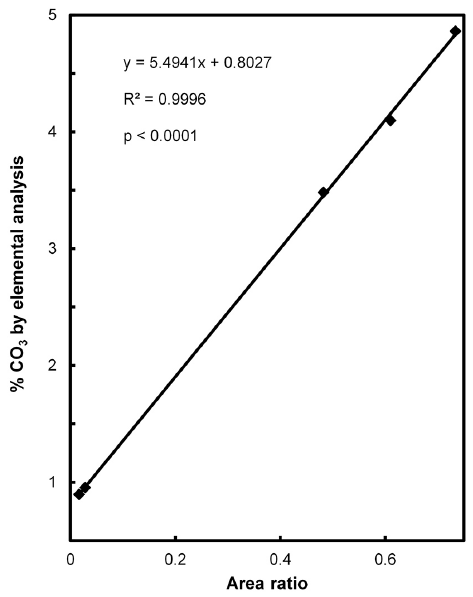
Figure 2. FTIR calibration for carbonate content determination of calcium phosphate minerals. Ratio of the extinction of the FTIR carbonate band to phosphate band (areas, E 1380 − 1440 /E 550 − 590 ) vs. carbonate content (% by weight) determined by elemental anal- ysis. For calibration, data of five minerals with known CO 3 content were used (cf. Table 1, minerals with performed elemental analy- sis). Contents of other minerals listed in Table 1 were calculated us- ing the indicated correlation (method after Featherstone et al., 1984 with